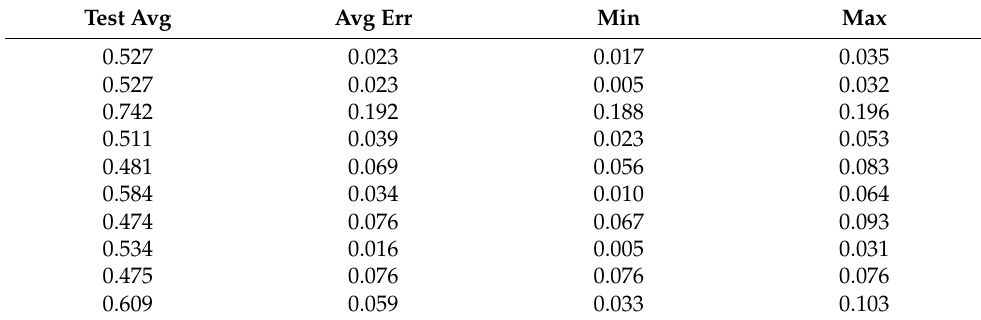
Table A69. Set 1, trials 41–50 data (all 0.5 PR values).